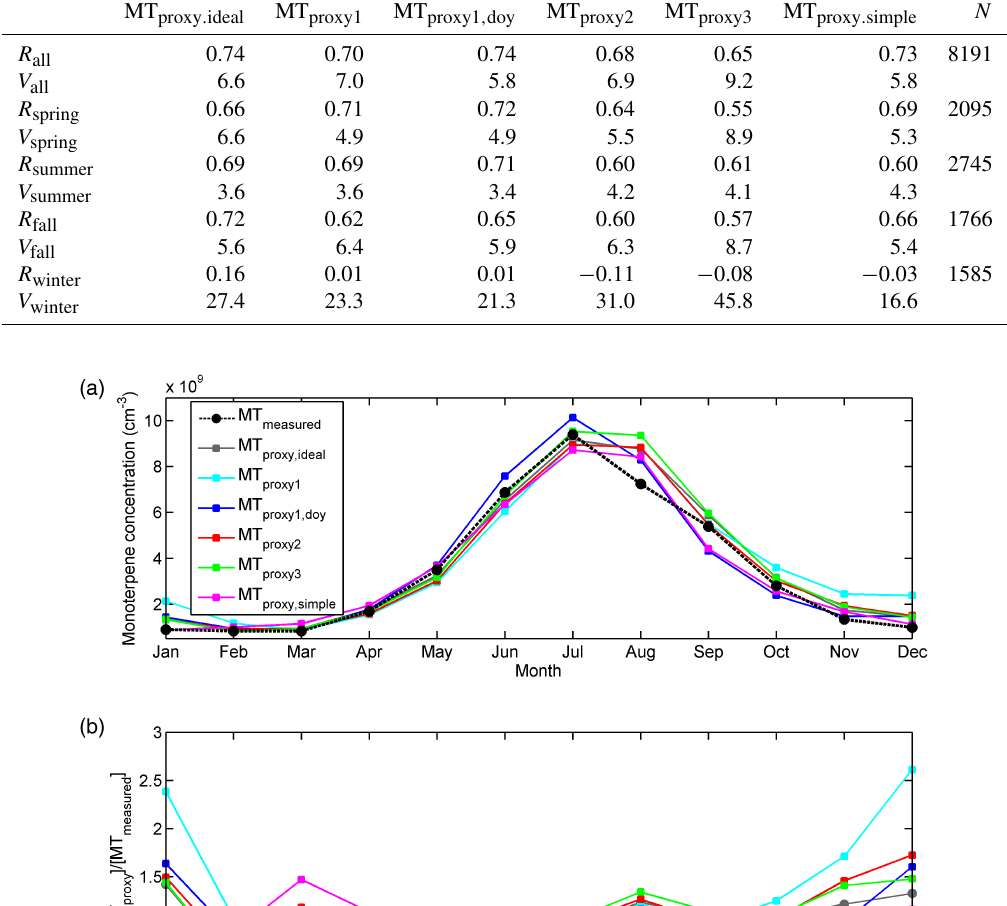
Table 3. Pearson correlation coefficient ( R ) and V 90 / 10 values between different proxies and the measured monoterpene concentration for all data and different seasons. The number of data points ( N ), of which the correlation coefficient was calculated, is shown in the last column.